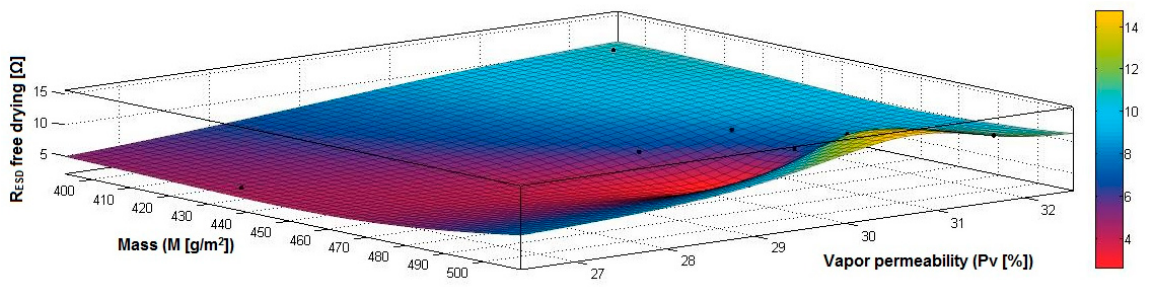
Figure 23. 3D representation R ESD free drying = f(Pa, Pv) for samples preliminarily treated in RF plasma O 2 using RF 1 generator and power 200 W.